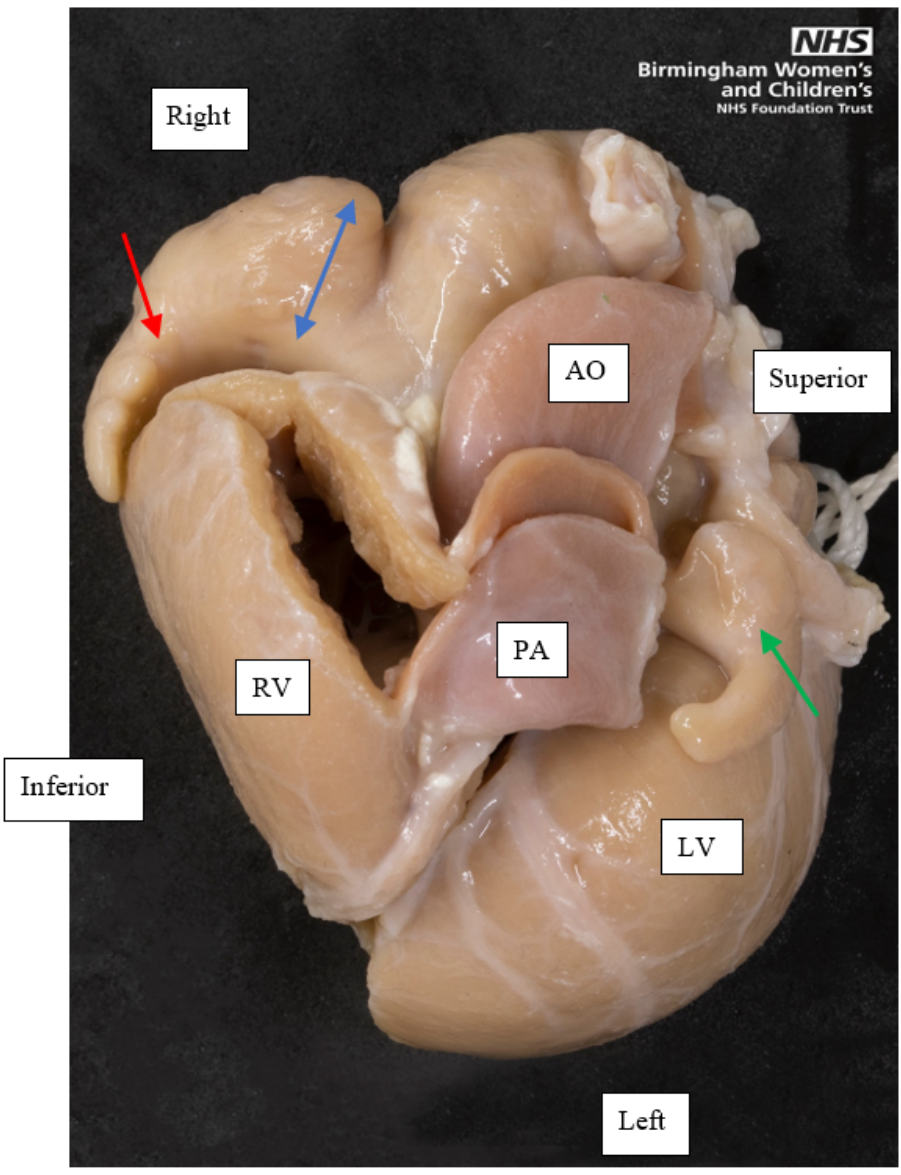
Figure 1. A superior view of the base of a heart with left atrial appendage isomerism, showing the external appearance of both appendages. The left-sided appendage, indicated by the green single-headed arrow, is small and tubular. The right-sided appendage, indicated by the red single-headed arrow, is tubular at its distal parts, but its proximal part is broad based, shown by the blue double-headed arrow. The pectinate muscle of both appendages was confined to the appendage (not shown in this image), confirming this as a heart with left atrial appendage isomerism. Orientation points displayed in an attitudinally correct fashion. AO, Aorta; PA, Pulmonary artery; RV, Right ventricle; LV, Left ventricle.